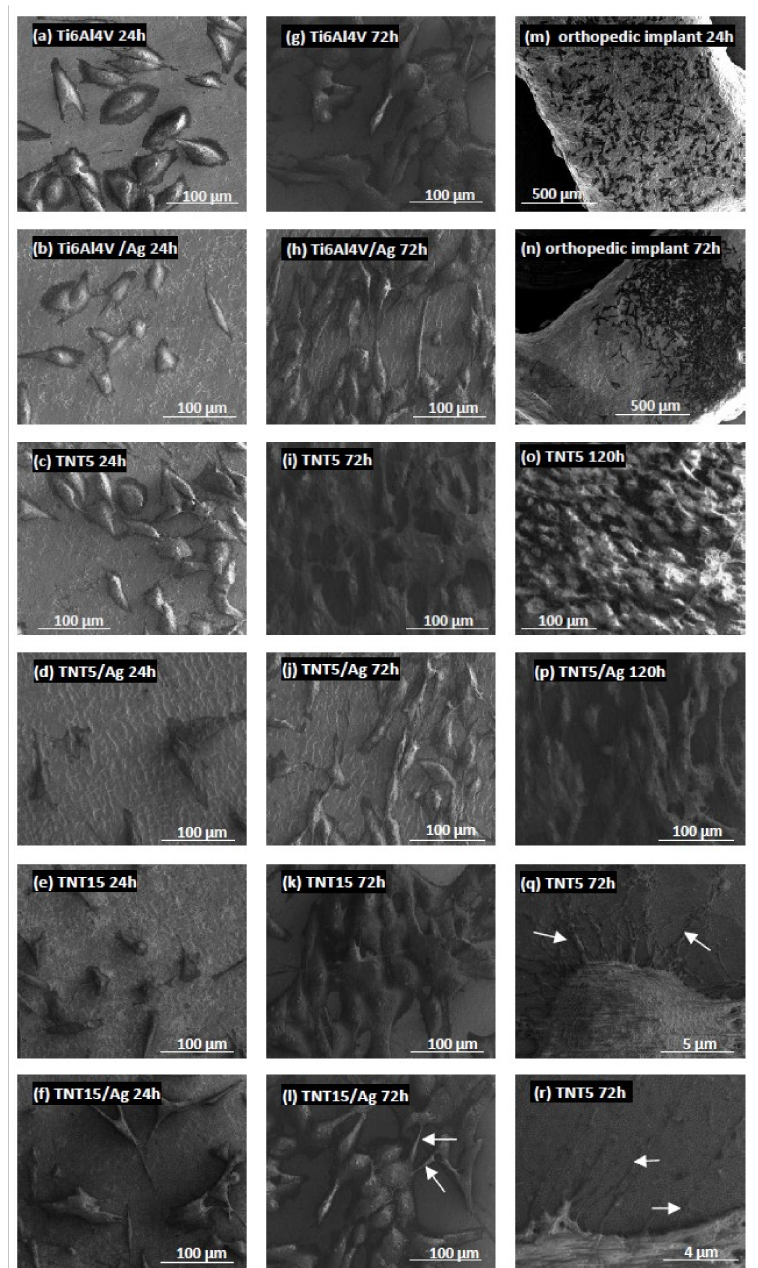
Figure 3. Scanning electron microscopy (SEM) images showing human osteoblast-like MG-63 cells that grow on the surface of the tested titania coatings and the reference Ti6Al4V alloy foils enriched or not with silver nanograins. Micrographs ( m , n ) present the cells grown on the surface of Ti6Al4V orthopedic implants, which were produced using selective laser sintering 3D technology. Arrows in image ( l ) indicate filopodia spread between cells and those in image ( q , r ) present filopodia penetrating deep into the samples and attaching the cells to the surface. The type of sample, cell incubation time, and scale of the images are shown in the figures as